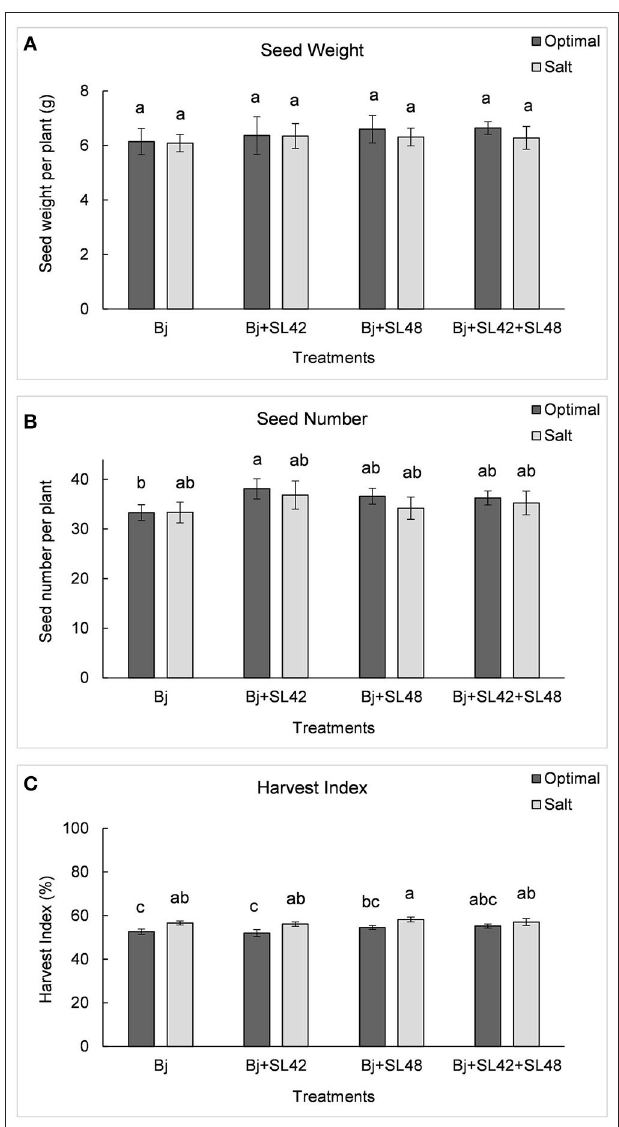
FIGURE 10 | Yield variables of soybean plants measured after harvest (A) seed weight, (B) seed number, and (C) harvest index under optimal (water) and salt (150mM NaCl) conditions. The seeds were bacterized with Bradyrhizobium japonicum (Bj), Bj + SL42, Bj + SL48, and Bj + SL42 + SL48. Values represent mean ± SE ( n = 12). Scheffe grouping for least square means was used for multiple means comparison and means with the same letter(s) are not significantly different ( α =